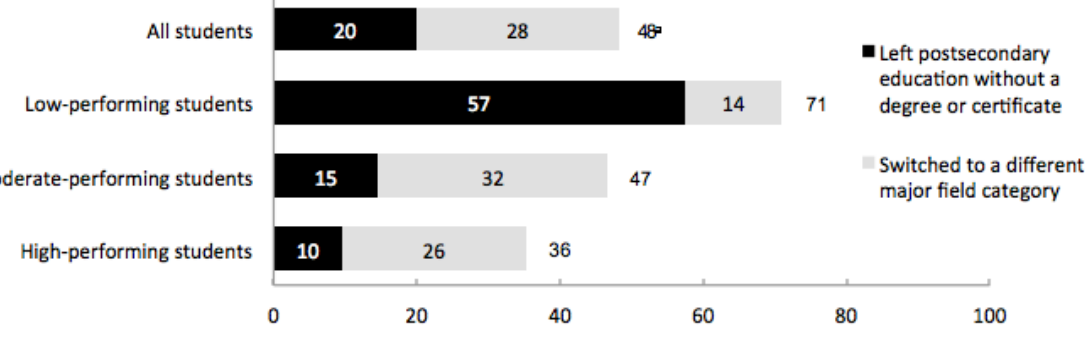
Figure 2. Percentage of STEM entrants who lef STEM felds: 2003-2009